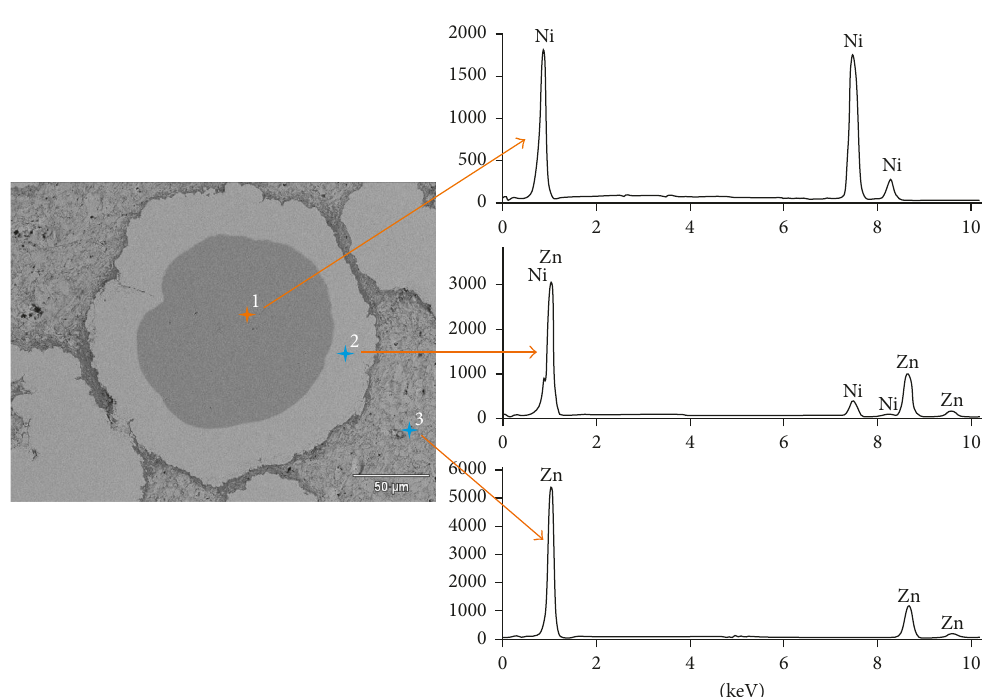
Figure 10: SEM micrograph and EDS spectra of the Zn-Ni